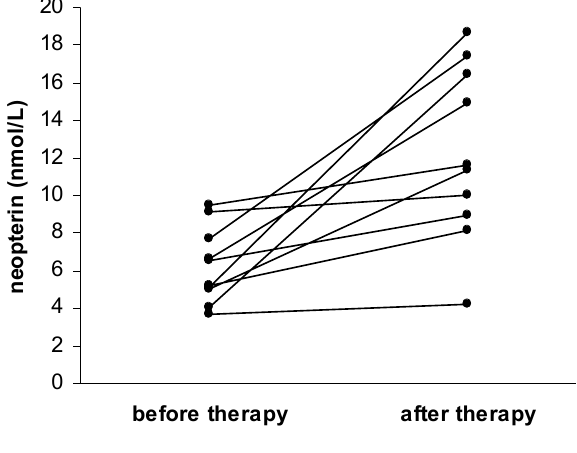
Figure 1. Serum neopterin concentrations before and after